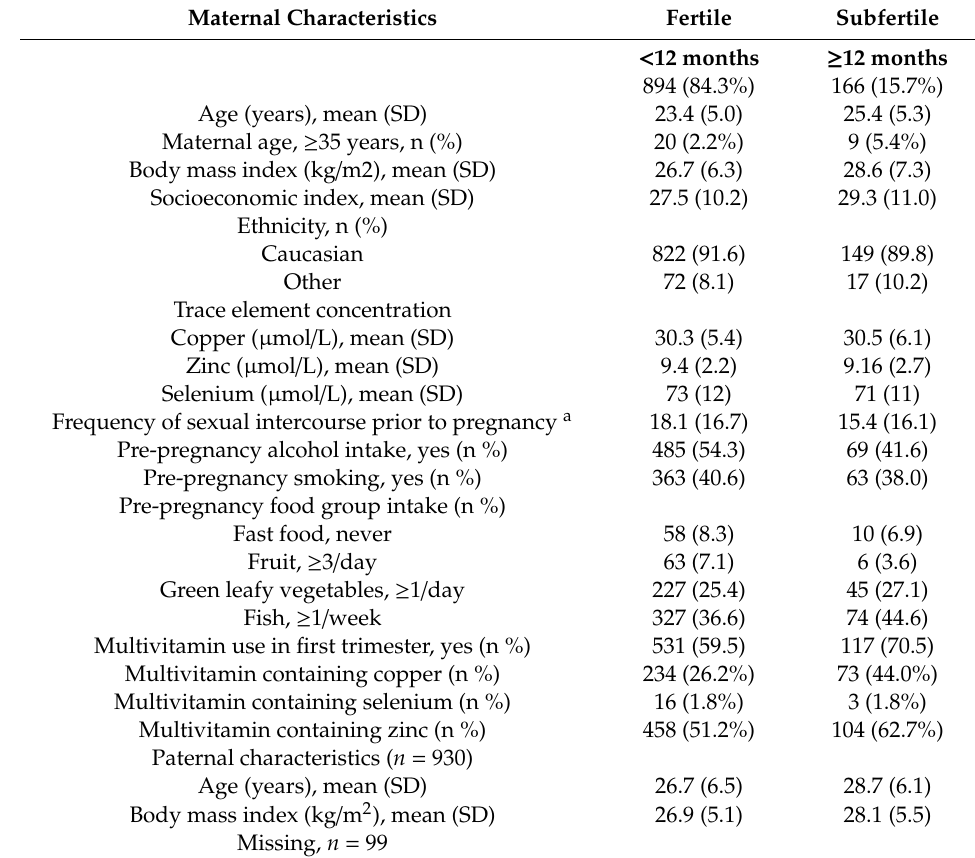
Table 1. Characteristics of the study population ( n =